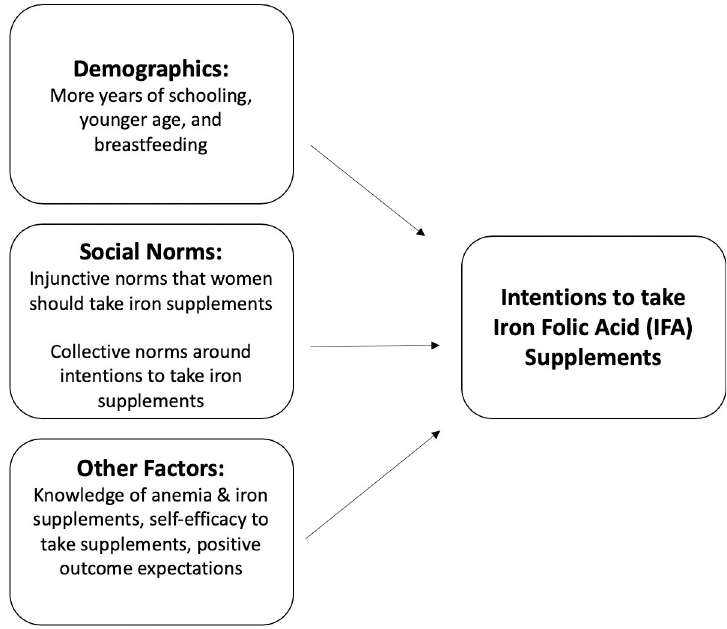
Fig 1. Visual depiction of factors associated with intentions to take iron folic acid